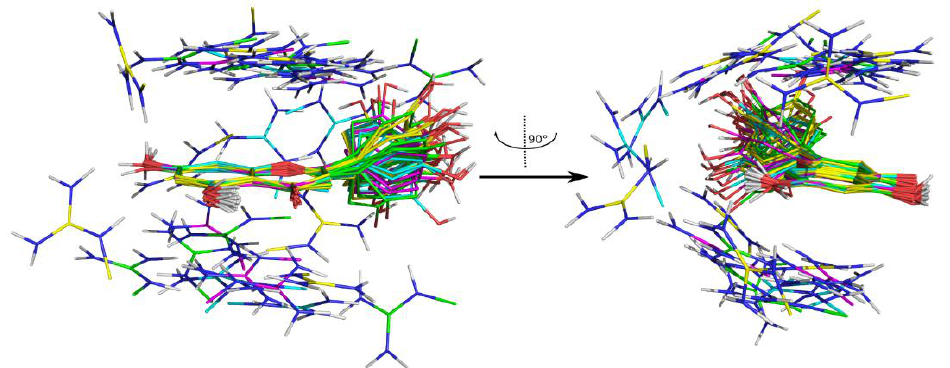
Figure 3. REST MD trajectories clustering of i1-4 rutin/ L -arginine. The structure nearest to the cen- troid for each highly populated cluster (>100 members) is represented in sticks and colored accord- ing to the following scheme: i1-magenta, i2-yellow, i3-green, i4-cyan.